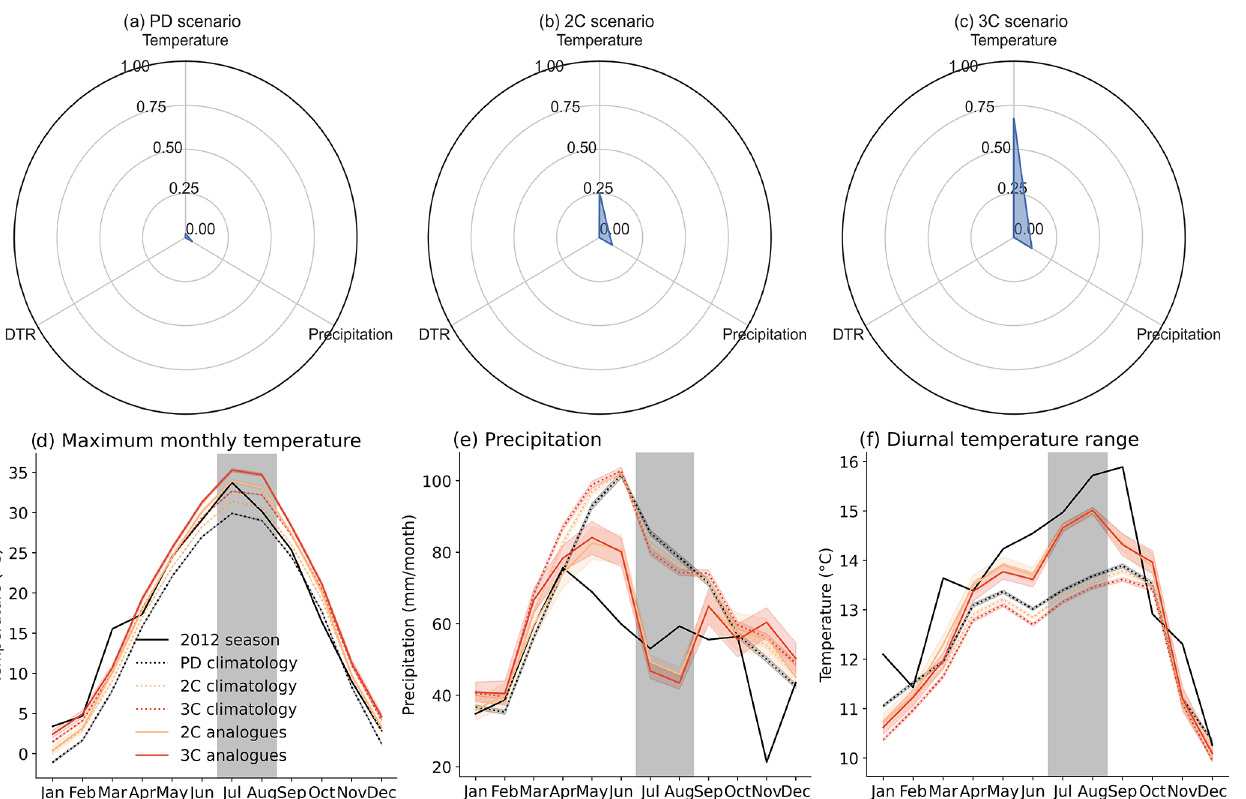
Figure 10. Radar graphs showing the number of seasons exceeding the 2012 values for each meteorological variable for present-day (a) , 2 ◦ C global warming scenario (b) and 3 ◦ C global warming scenario (c) scenarios. Annual cycle of the historical years, the 2012 season, the impact analogues and their corresponding climatology for maximum monthly temperature (d) , precipitation (e) and diurnal temperature range (f) . Coloured shadings represent the 95% confidence interval for each scenario. The vertical grey bar represents the months considered in the training of the RF